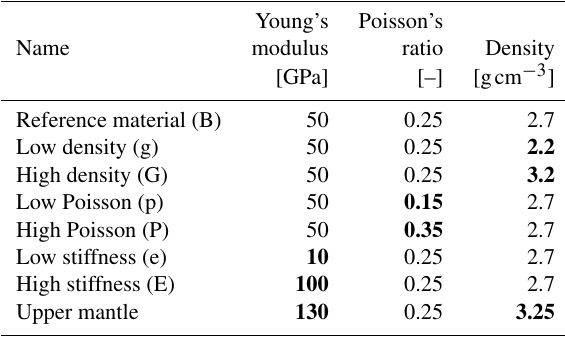
Table 2. Young’s modulus, Poisson’s ratio and densities used in the models. Bold numbers indicate the properties used, which differ from those of the reference